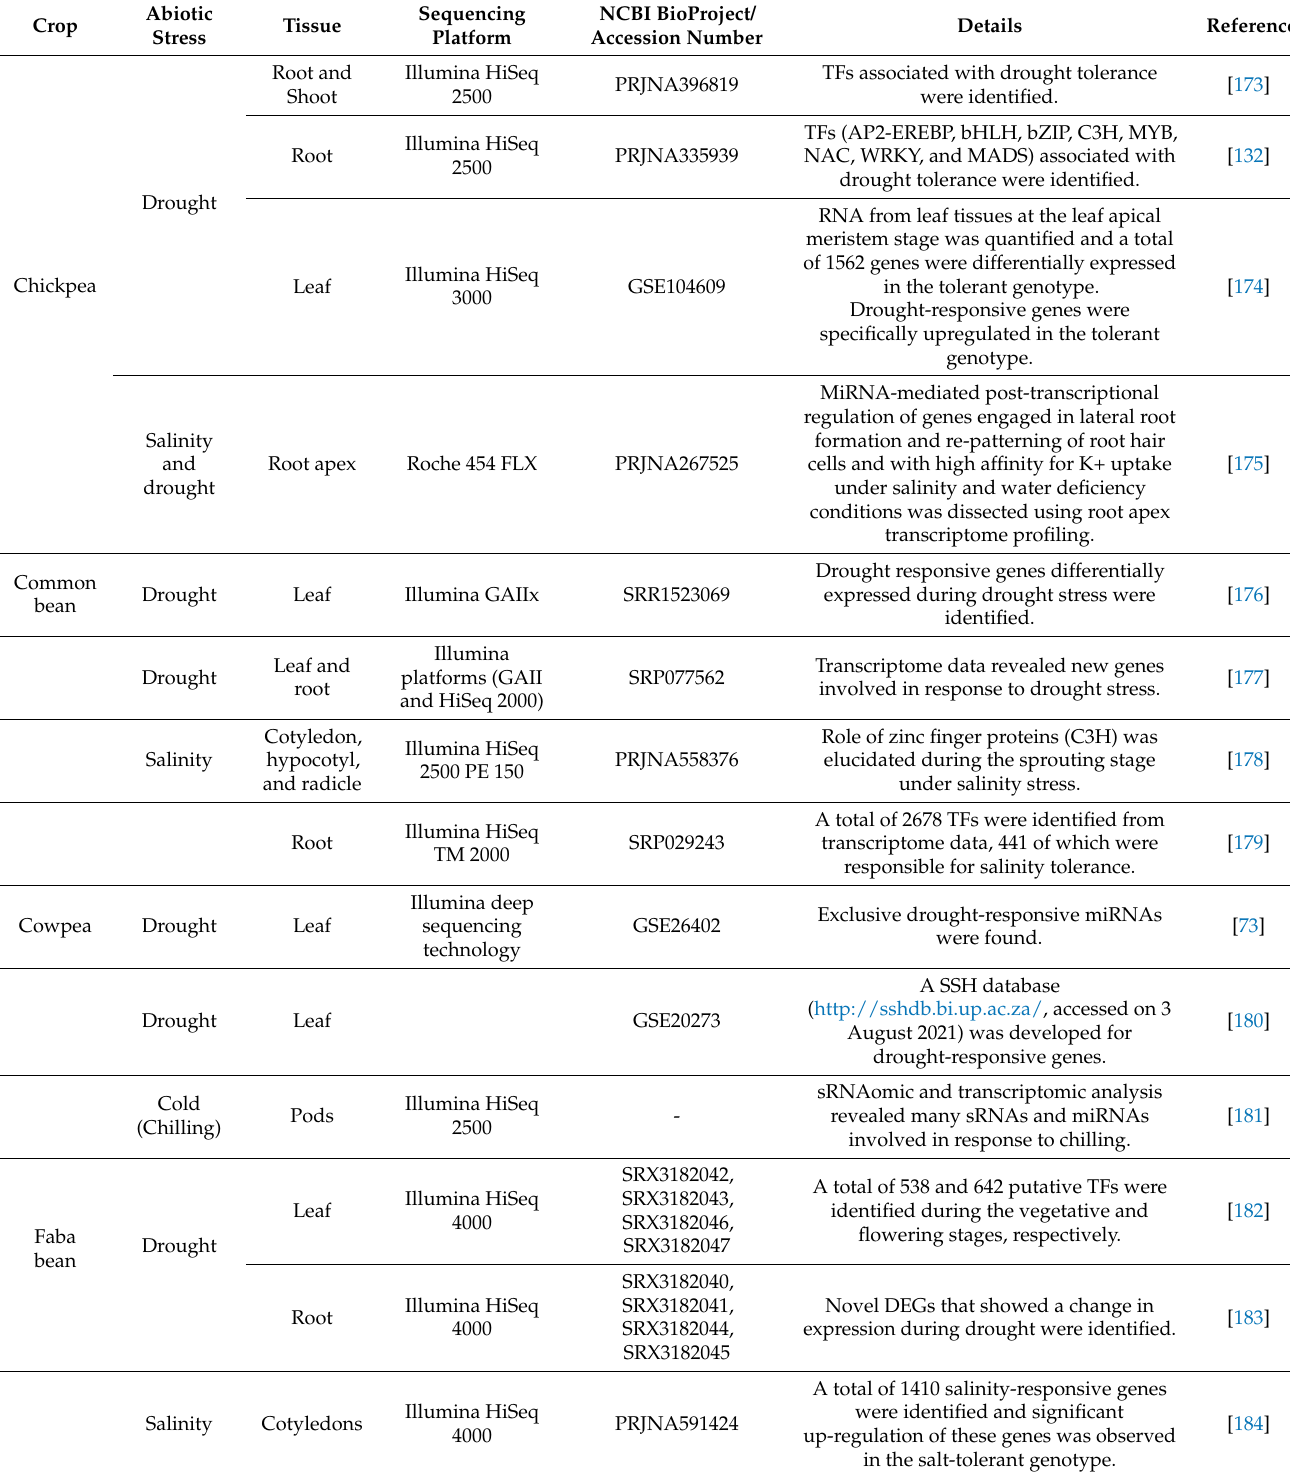
Table 5. RNA-Seq for transcriptome profiling of pulse crops under abiotic